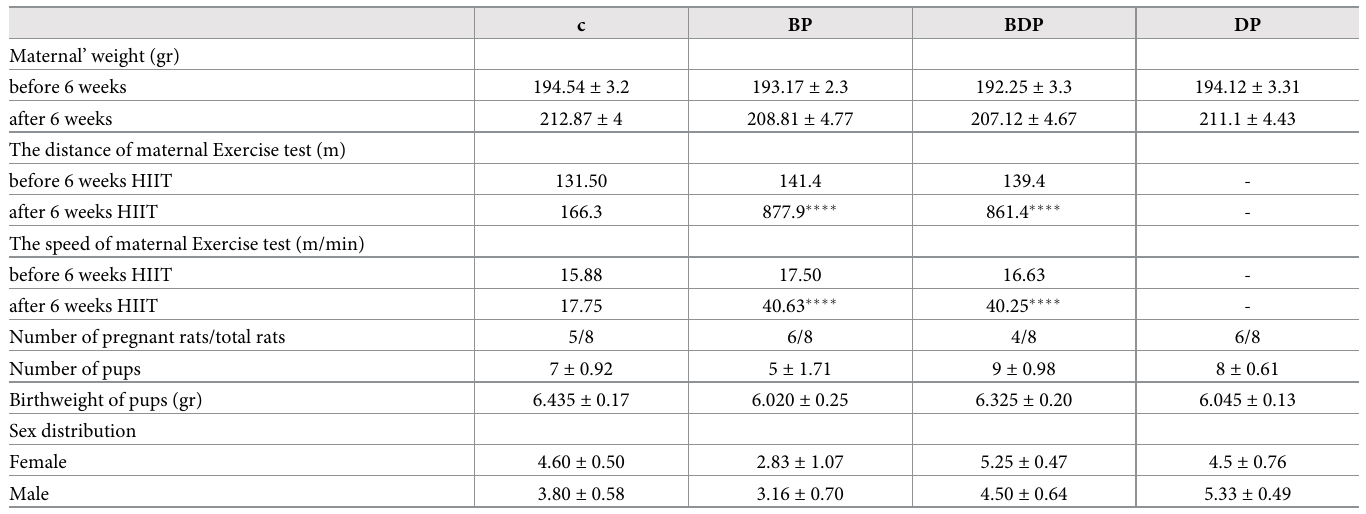
Table 4. Maternal characteristics.